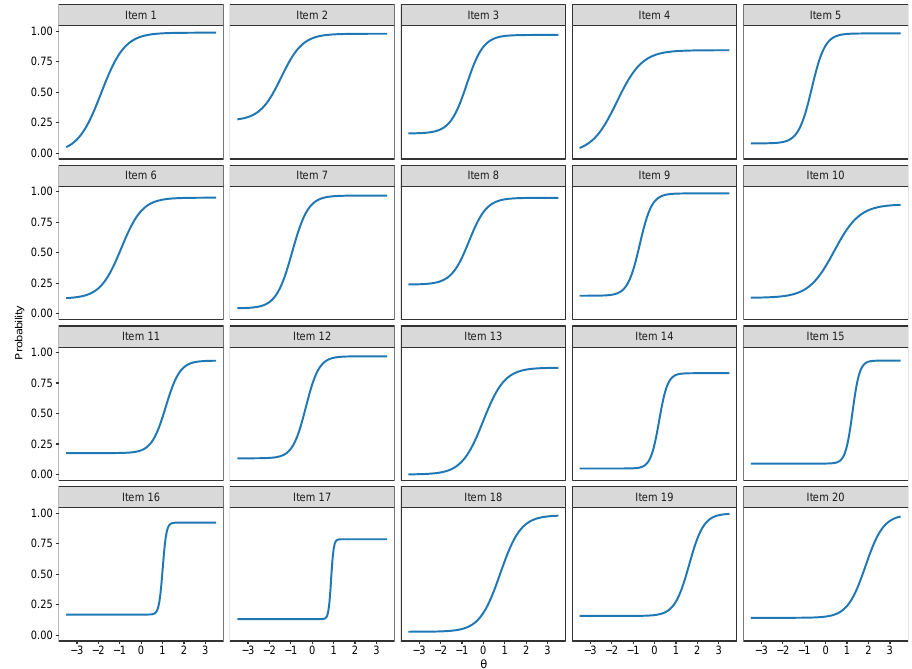
Figure 4. Item characteristic curve plots of the 4-Parameter Logistic Model.